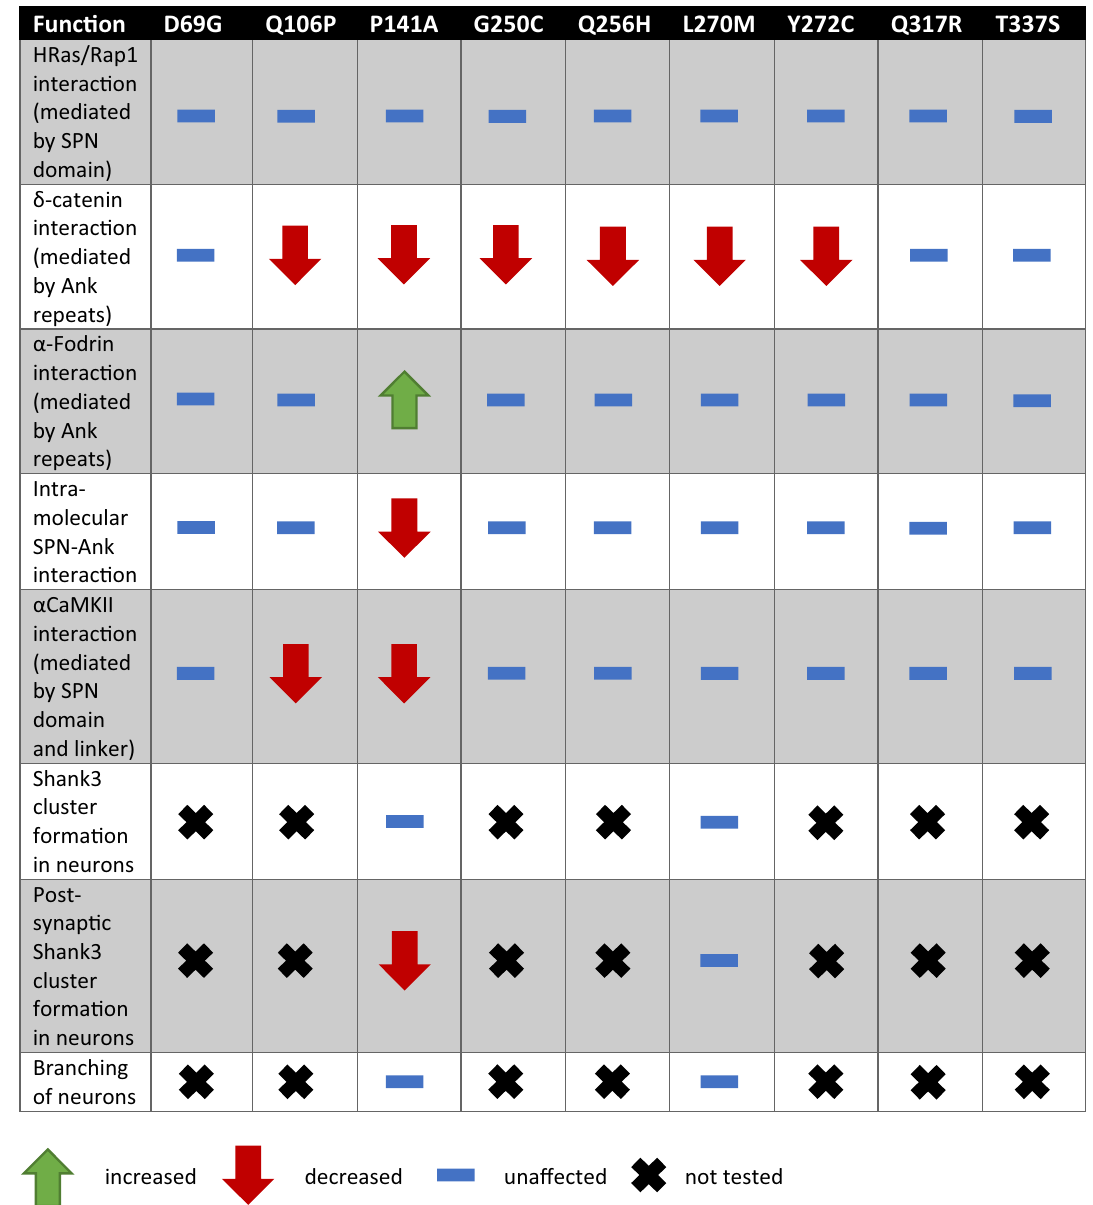
Table 2. Summary of the functional analysis of the examined SHANK3